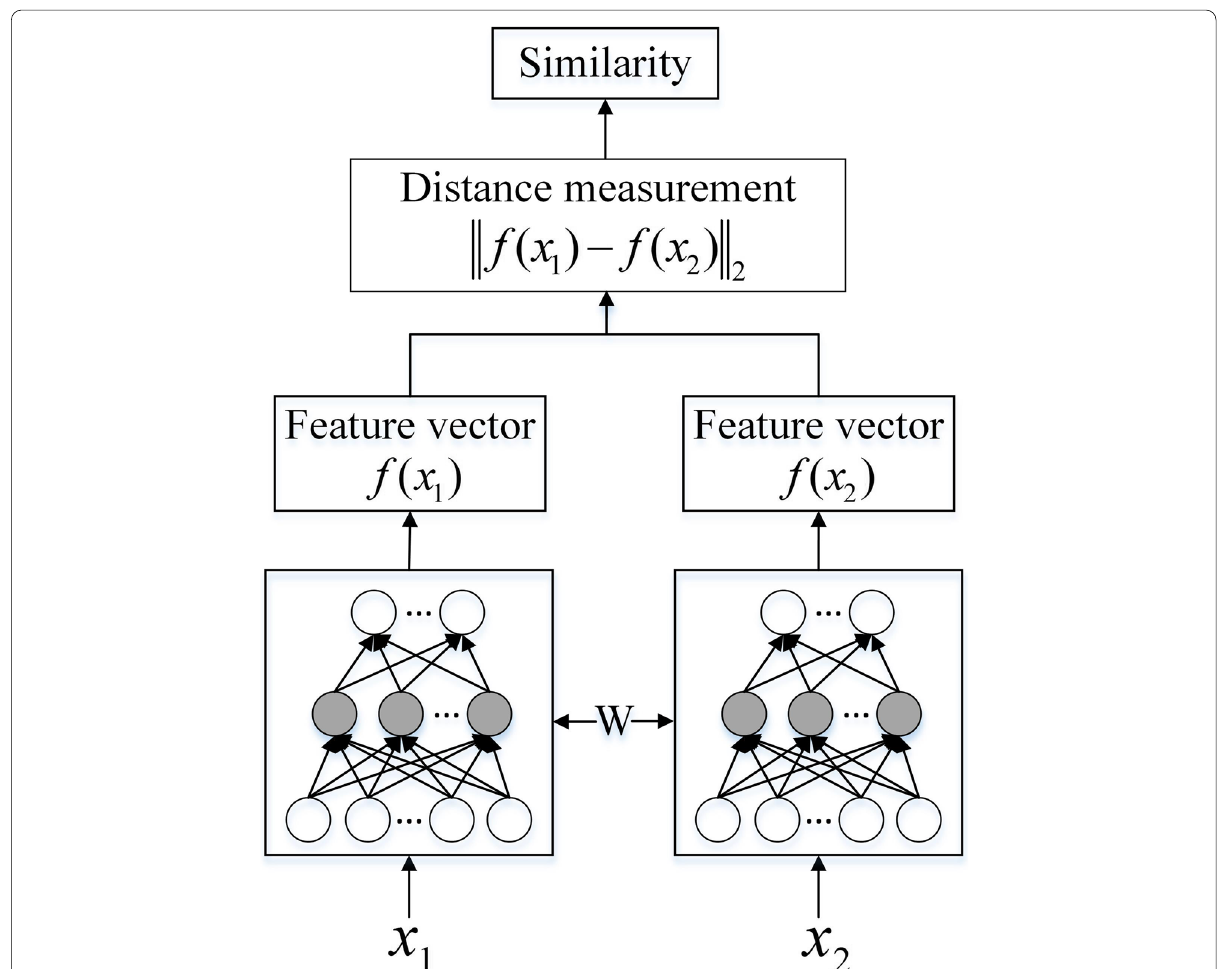
Fig. 1 Structure of Siamese network.The input of the Siamese neural network is a pair of samples, and the output is the similarity between them. When two samples belong to the same category, the similarity value approaches 1; when the two samples belong to different categories, the similarity value approaches